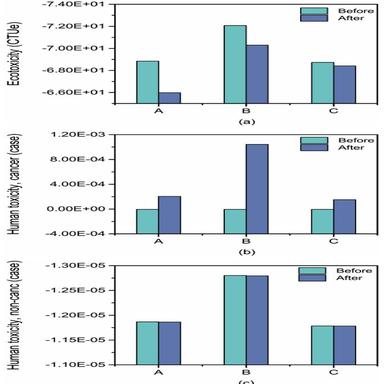
Ecotoxicity and human toxicity impacts of three advanced wastewater treatment processes and taking into account 126 PPCPs in the LCI. (Before represents not involving PPCPs in advanced wastewater treatment processes, after represents involving PPCPs in the LCI. A, B, C represents scenario A, B, and C).